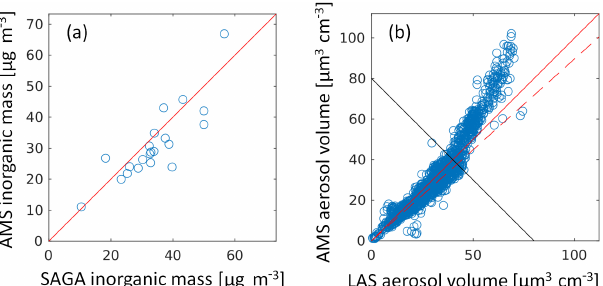
Figure 3. (a) Scatterplot of total inorganic aerosol (sulfate, ammo- nium, chloride, and nitrate) mass (µgm − 3 ) as measured by SAGA and AMS, averaging the AMS data to the SAGA integration time ( R 2 = 0 . 72, slope = 1 . 07). The solid red line indicates the 1 : 1 line. (b) Scatterplot of aerosol volume measured by the AMS and LAS, accounting for the AMS transmission. The solid red line indicates the 1 : 1 line, the solid black line represents an approximate cutoff for the LAS saturation, and the dashed red line represents the re- gression line when using data below the black line (slope of